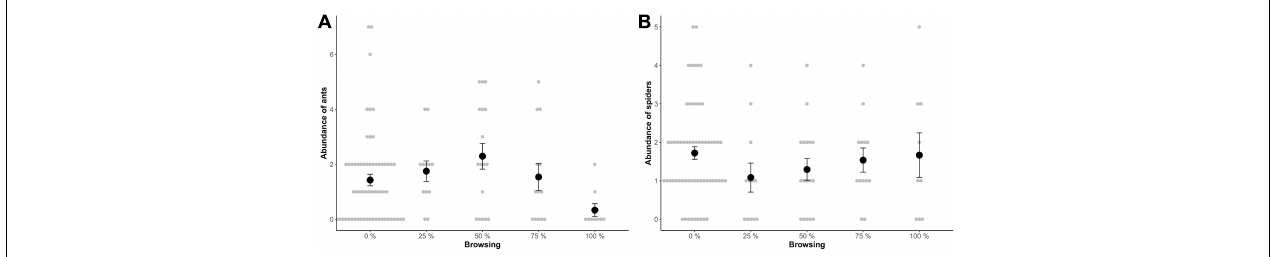
FIGURE 1 | (A) Abundance of ants and (B) abundance of spiders in relation to browsing intensity. Mean abundances were: (A) 1.43, 1.75, 2.29, 1.54, and 0.33 ants per 1.5 m sampled biomass per tree and (B) 1.76, 1.08, 1.22, 1.5, 1.7, spiders per 1.5 m samples biomass on un-browsed (control), 25, 50, 75, and 100% browsed trees, respectively. Error bars show standard error.